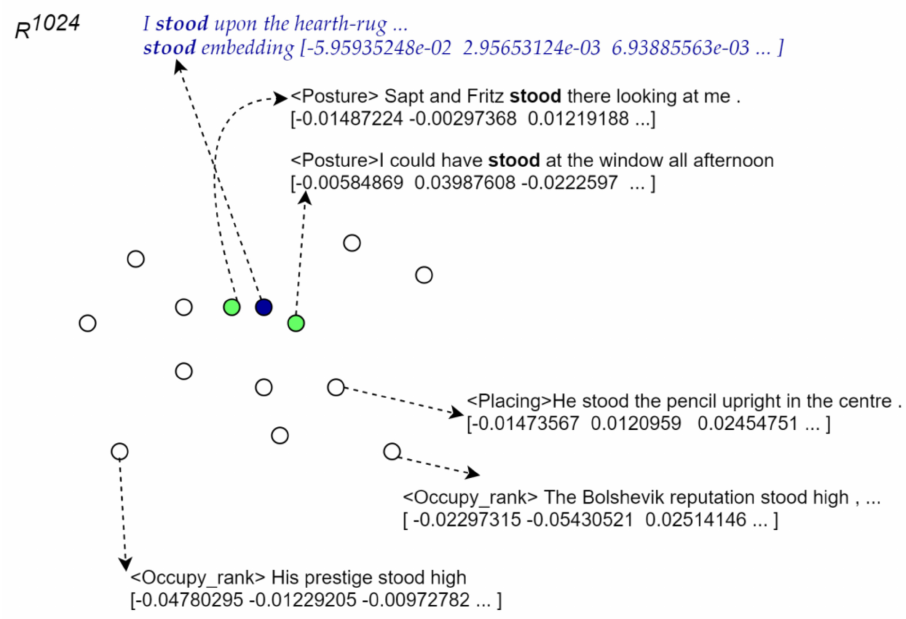
Figure 6. Frame identification using the k-NN approach for the new sentence (blue) and manually annotated examples from the FrameNet corpus (white and